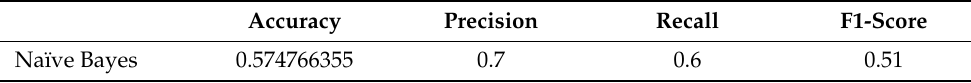
Table 2. Analysis of Naïve Bayes.